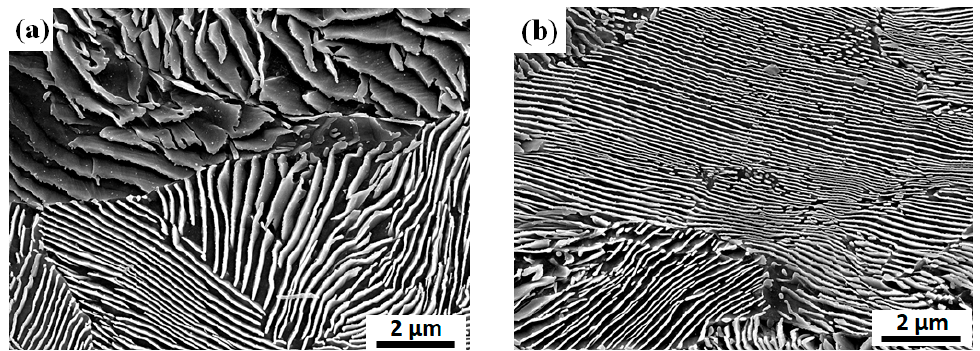
Figure 9. Comparison of representative microstructure at the central region of wire ring with ( a ) inline and ( b ) staggered arrangements.